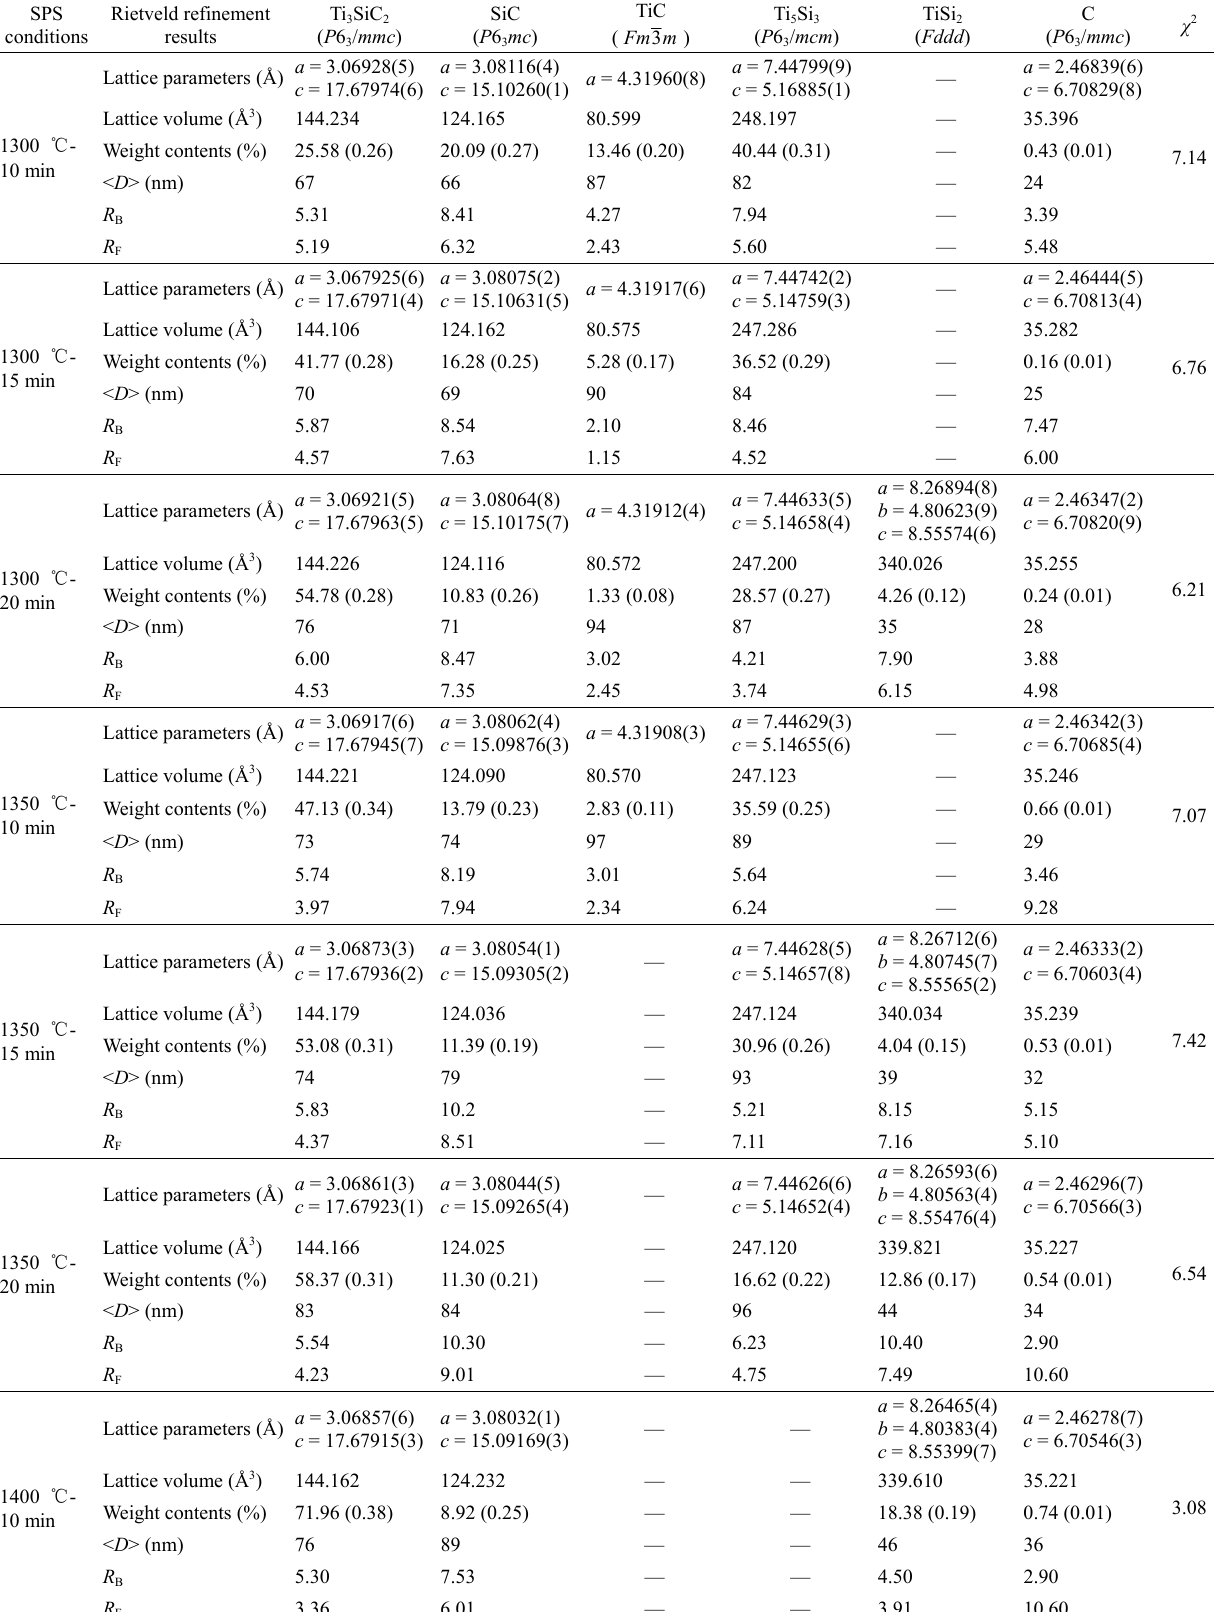
Table 1 Rietveld refinement results of the bulk materials sintered at 60 MPa by SPS starting from mixture of Ti–SiC SPS Rietveld refinement conditions